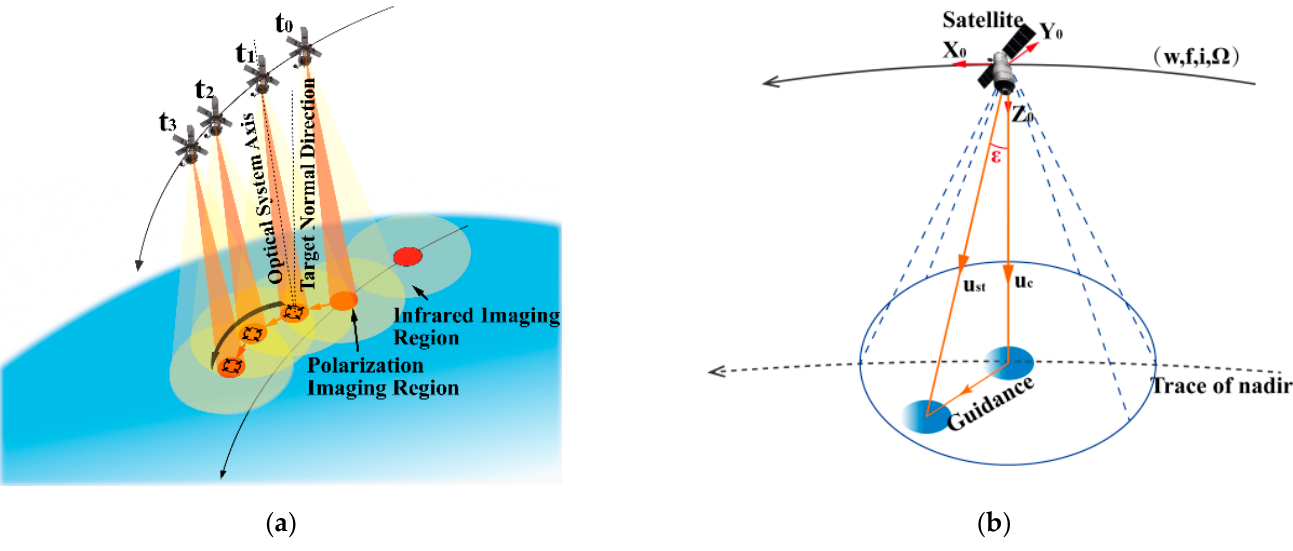
Figure 1. Principle diagrams of infrared-guided polarization imaging. ( a ) schematic diagram of infrared-guided polarization imaging. ( b ) schematic diagram of the satellite maneuvering path.